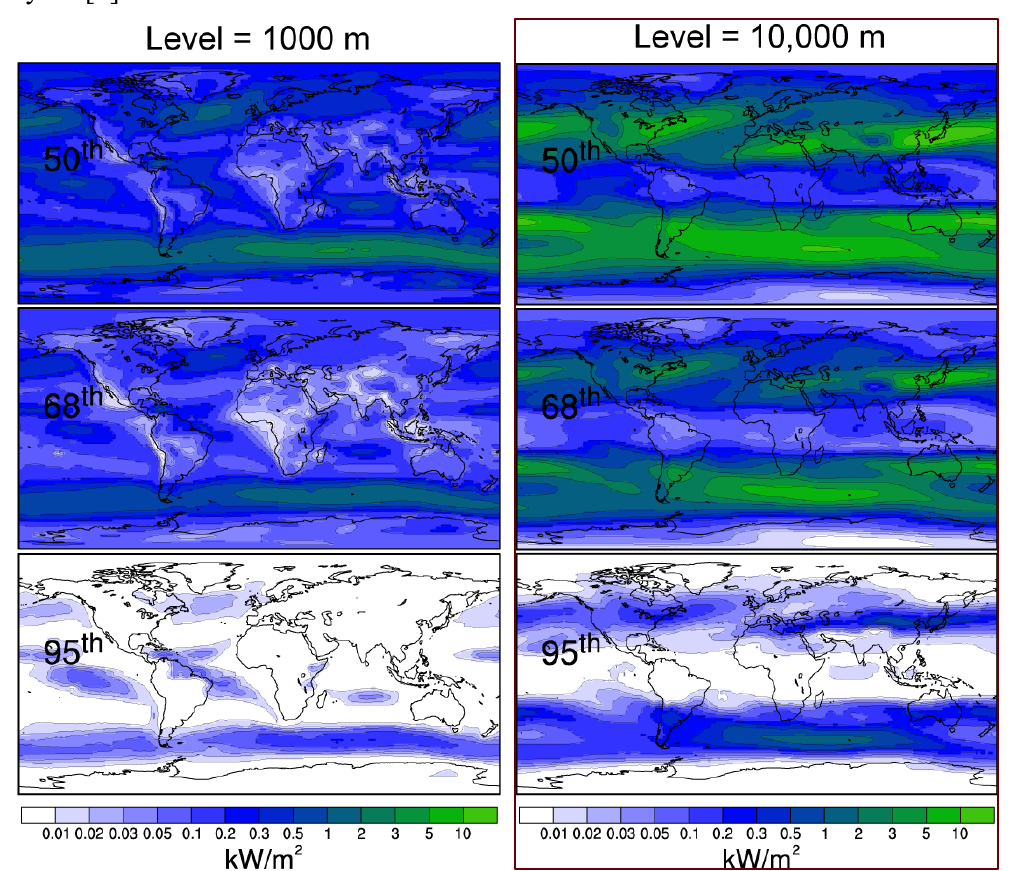
Figure 3. Wind power density (kW/m 2 ) that was exceeded 50%, 68%, and 95% of the time during 1979-2006 at 1,000 m (left) and 10,000 m (right) from the NCEP/DOE reanalyses